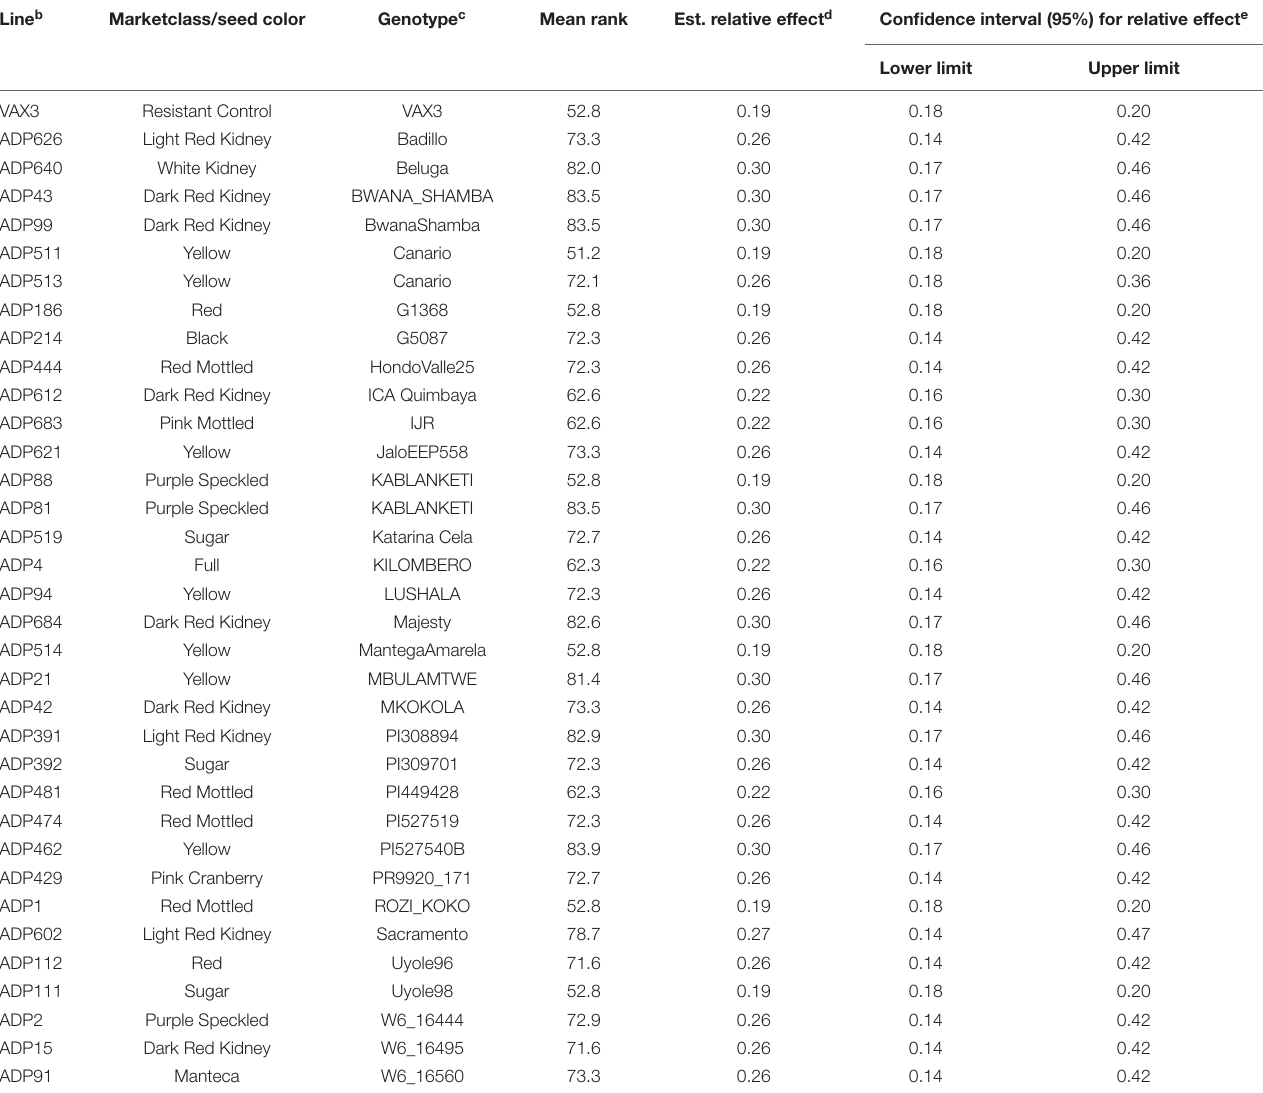
TABLE 2 | Common bean lines from the Andean Diversity Panel (ADP) classified as resistant when compared to the resistant control VAX3 based on overlapping confidence intervals and P- values ( α < 0.05) a . Line b Marketclass/seed